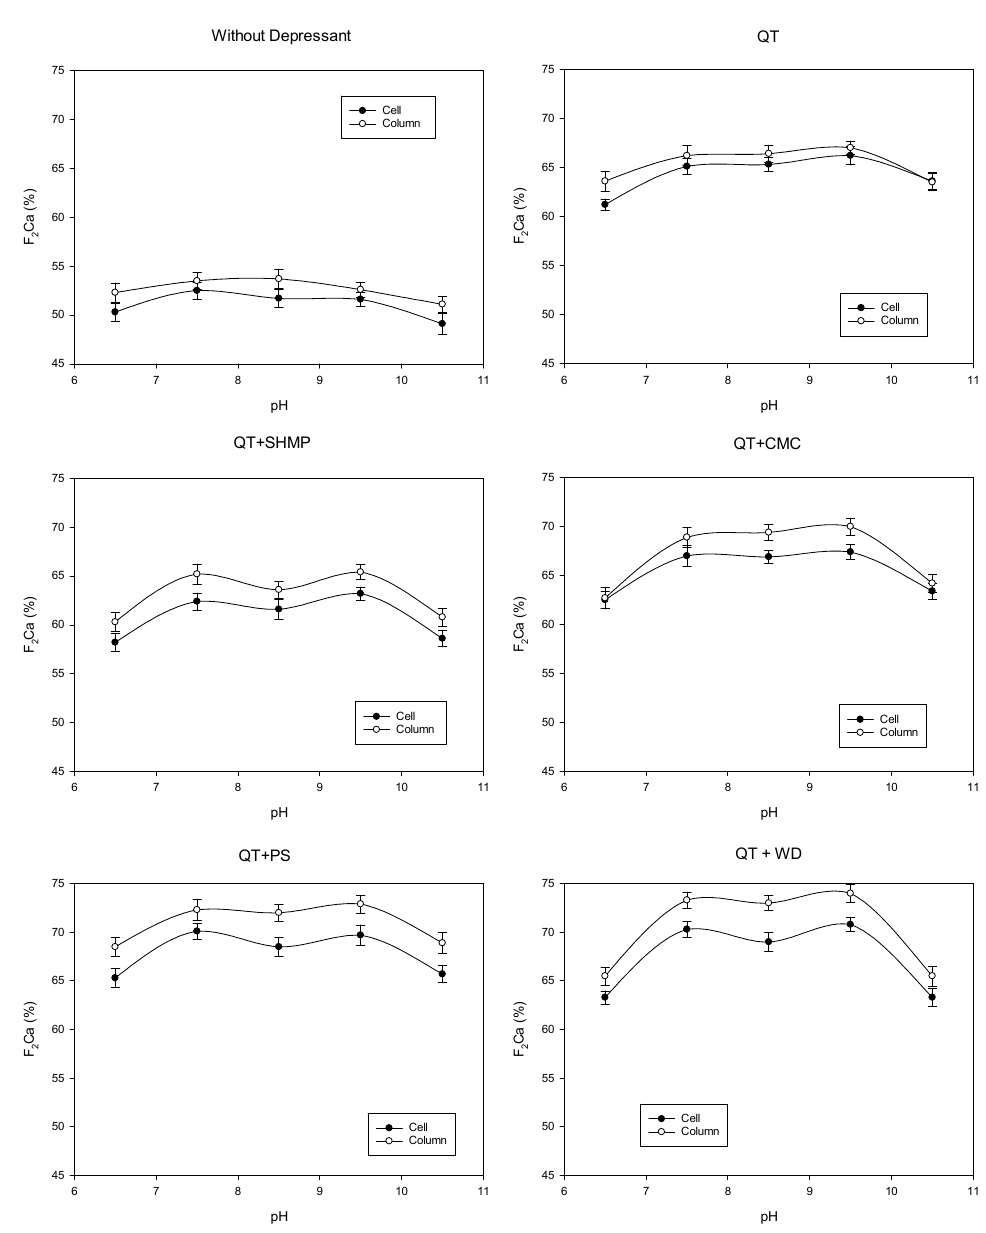
Figure 1. CaF 2 (%) on concentrate for cell and column as pH function and type of depressant.